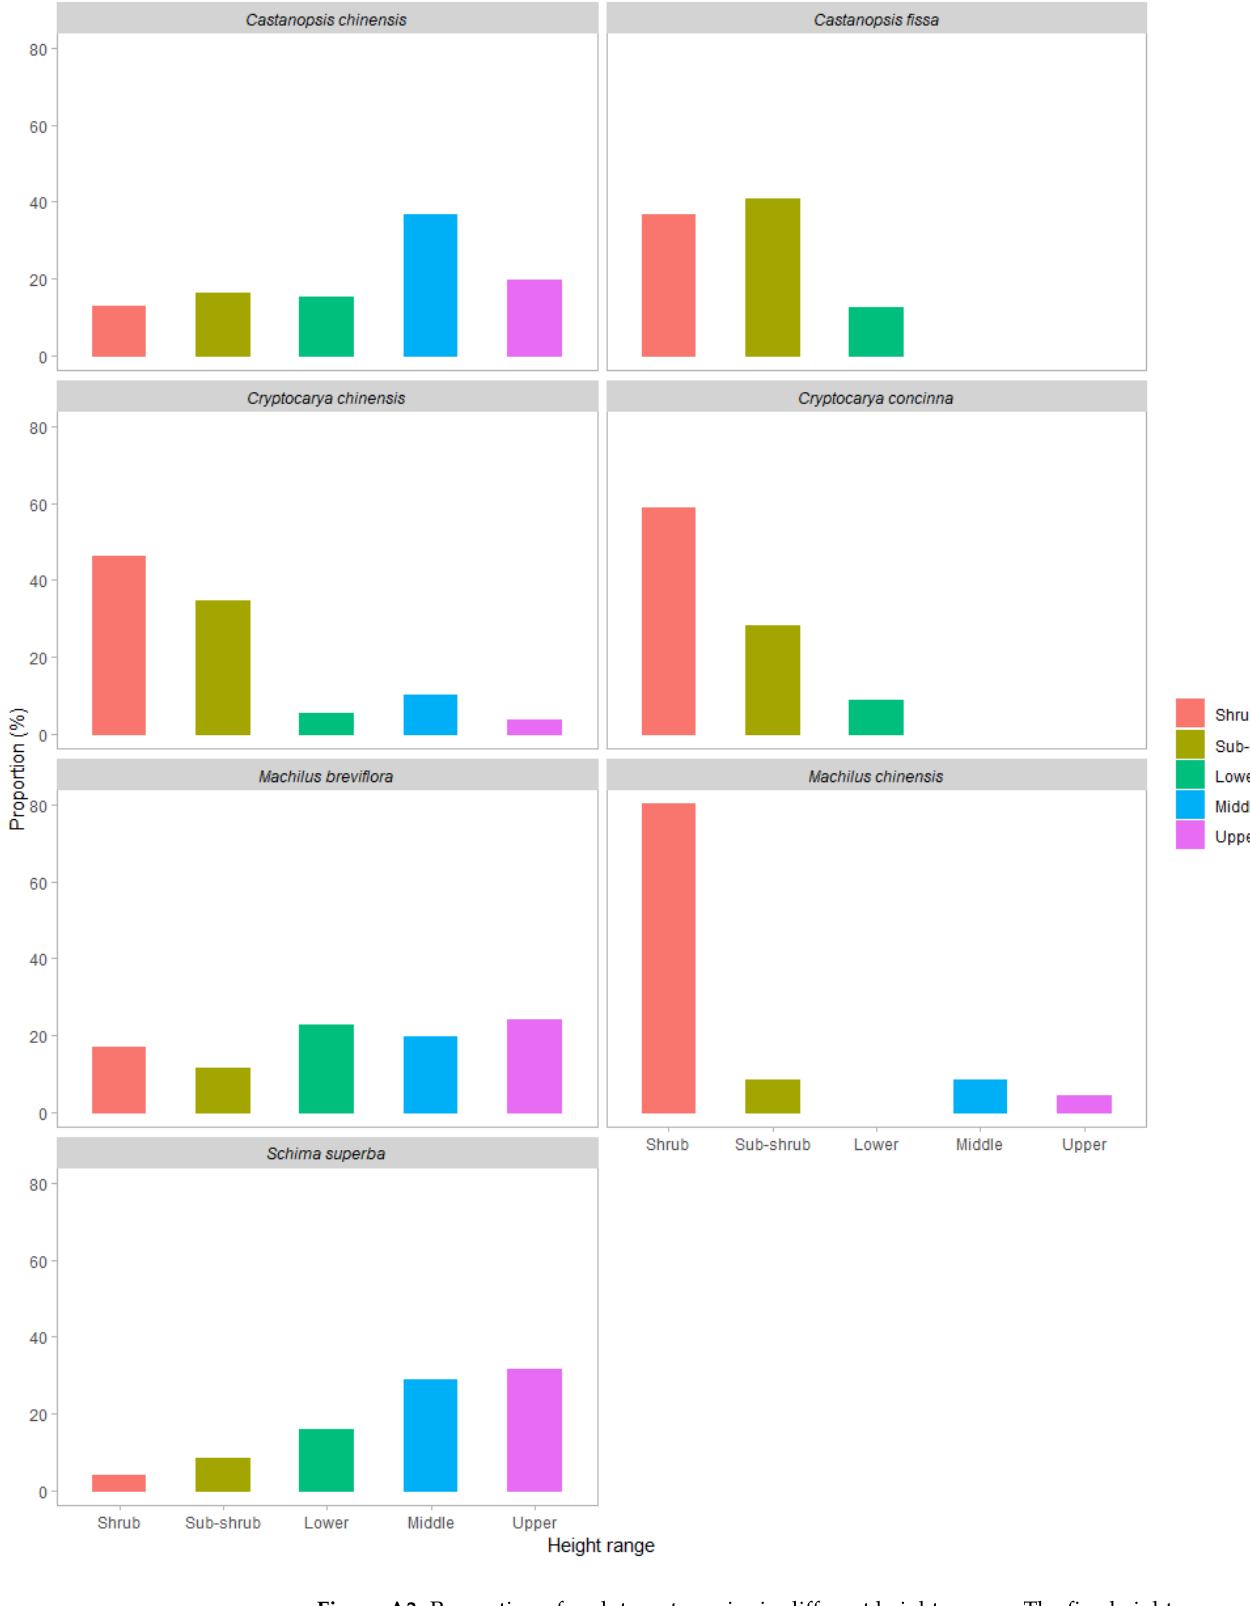
Table A1. Abundance of the seven target species.